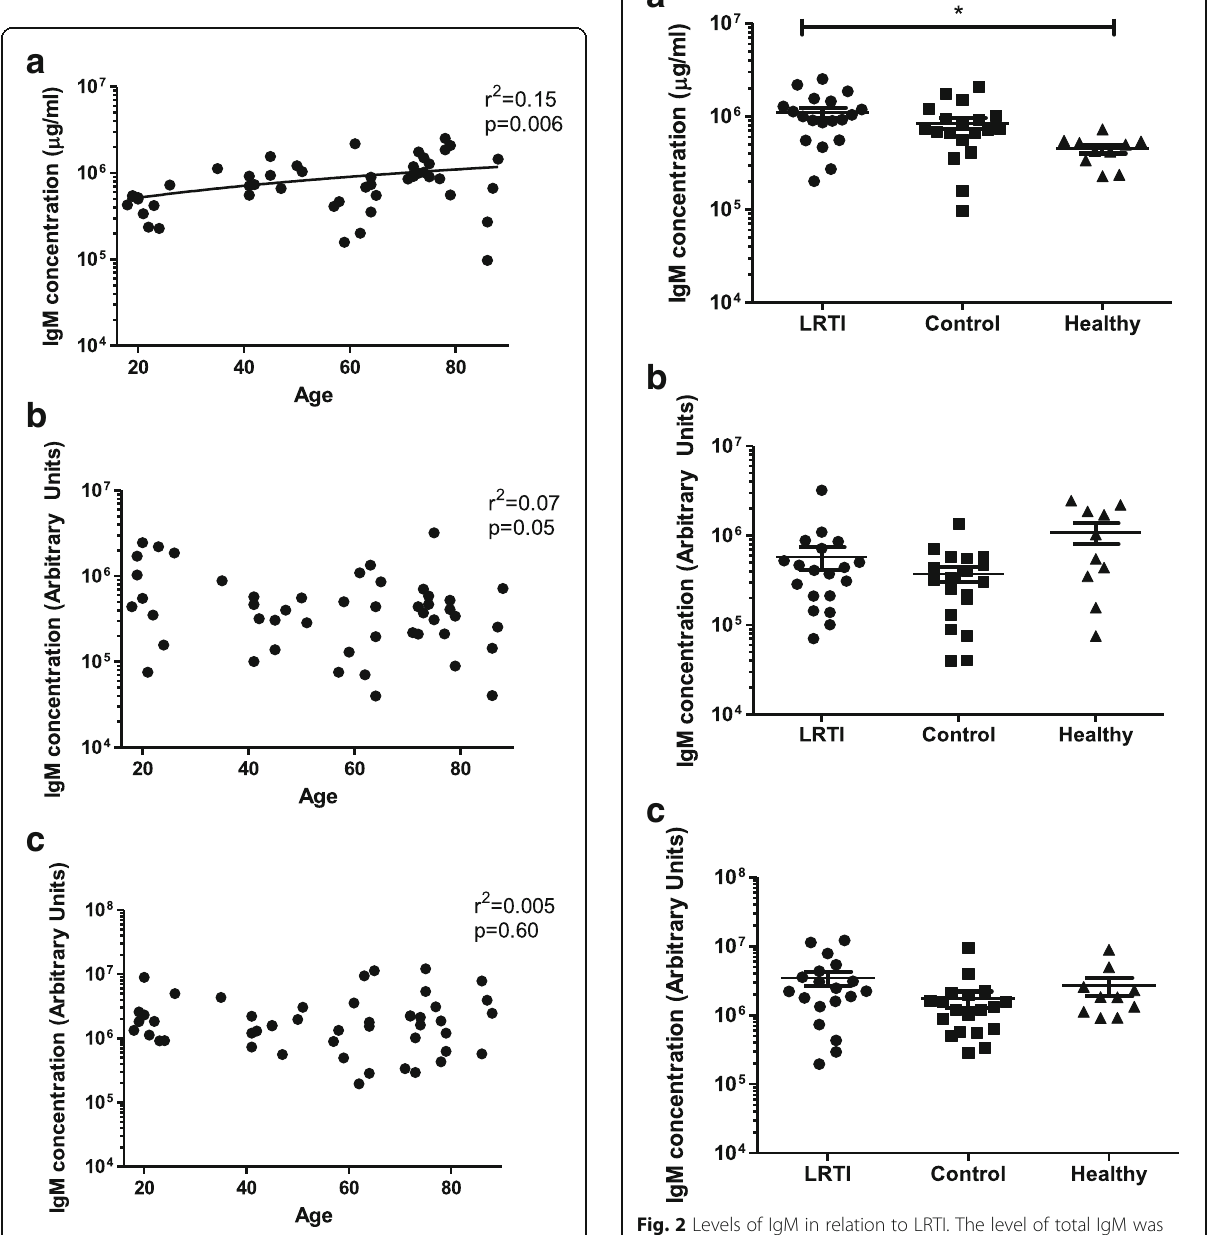
Fig. 1 Levels of IgM in relation to age. Levels of ( a ) total IgM, ( b ) IgM to the unencapsulated D39- Δ D pneumococcus and to the ( c ) Pneumococcal Surface Protein A (PspA4) were plotted against volunteer age. Correlations were analysed using linear regression analysis